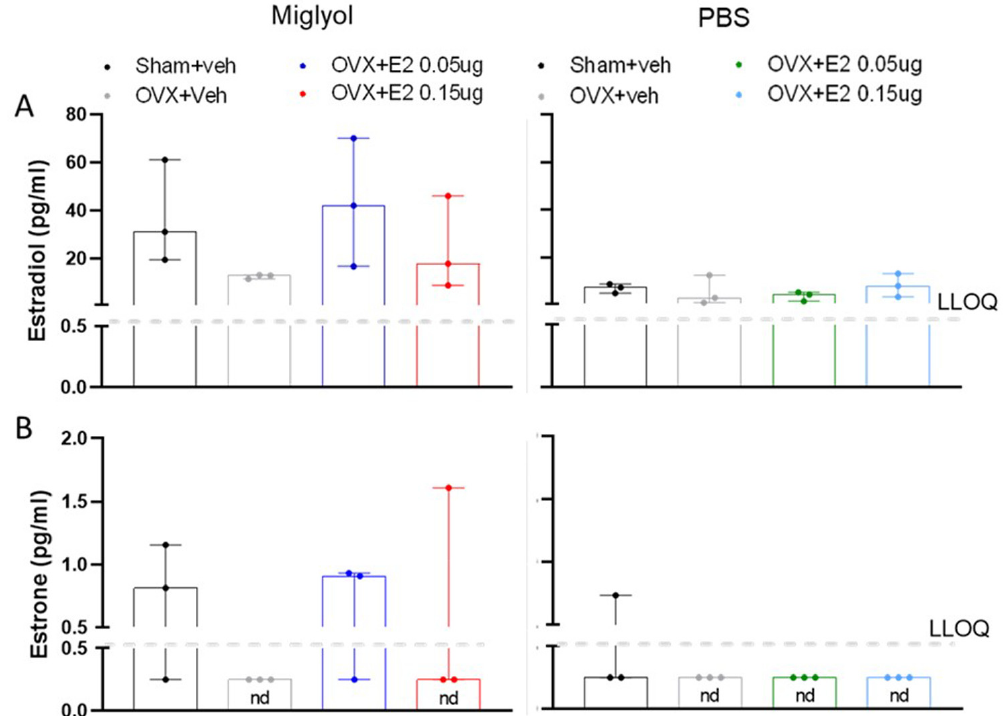
Figure 2. Levels of estradiol and estrone in serum after 8 weeks of treatments. The amount of estradiol ( A ) and estrone ( B ) was measured in Sham and OVX mice after 8 weeks of s.c. injections every 4 days with vehicle (miglyol or PBS) or 17 β-estradiol (E2; 0.05 µg/mouse or 0.15 µg/mouse). Data are expressed as median (range); n=3 for each experimental group. (nd = not detectable; LLOQ=lower level of quantification).